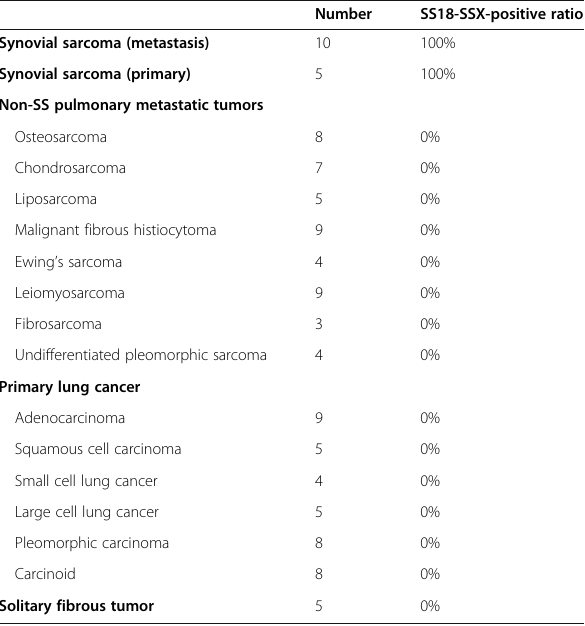
Table 2 Summary of the results of IHC staining for SS18-SSX antibody